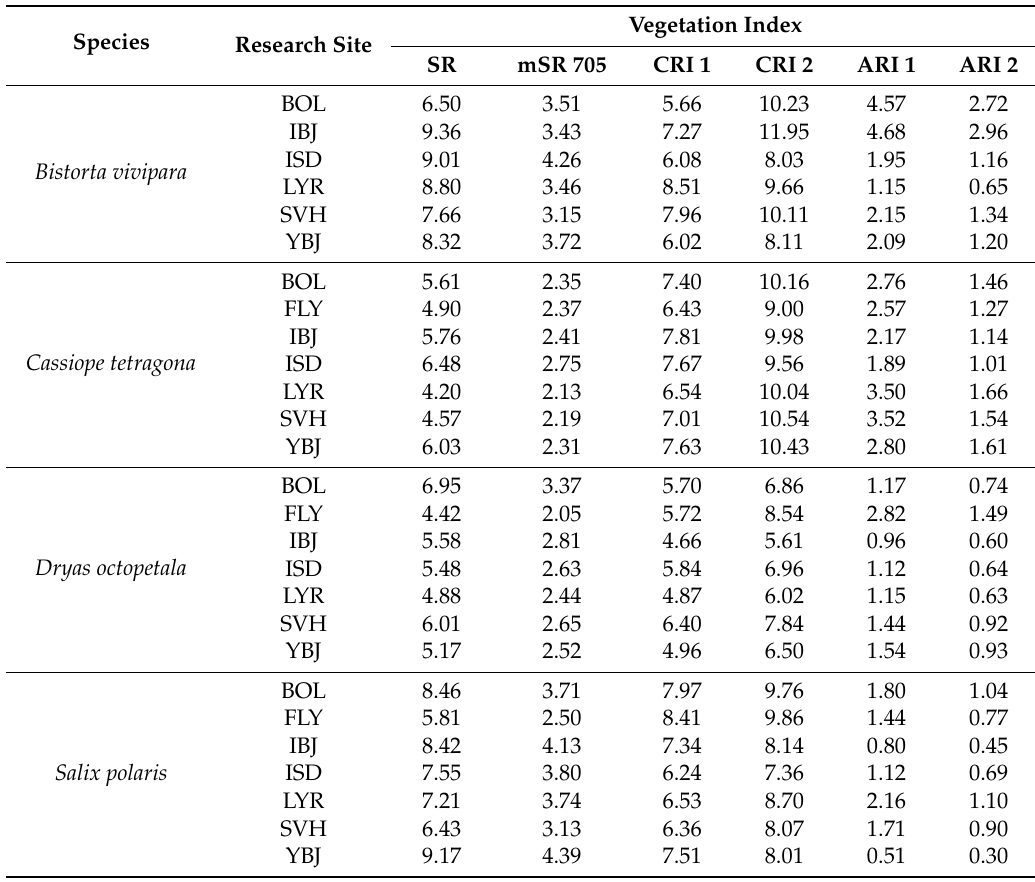
Table 7. Variability of vegetation indices (highest standard deviations between measurement sites); 1 and 2), and the Anthocyanin Reflectance Indices 1, 2 (ARI 1 and 2).